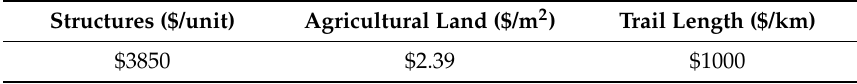
Table 3. Estimated costs of damage for different categories in 2016 US